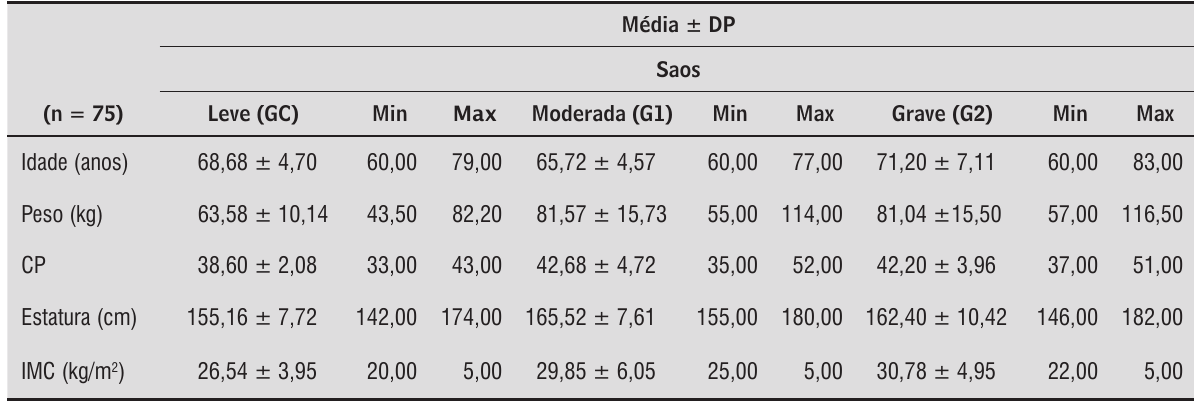
Tabela 1 - Valores descritivos da idade e características antropométricas (mínimo, máximo) média e desvio-padrão (DP) das variáveis antropométricas, divididos por grupo de